Question: Provide a one-line summary of what is displayed.
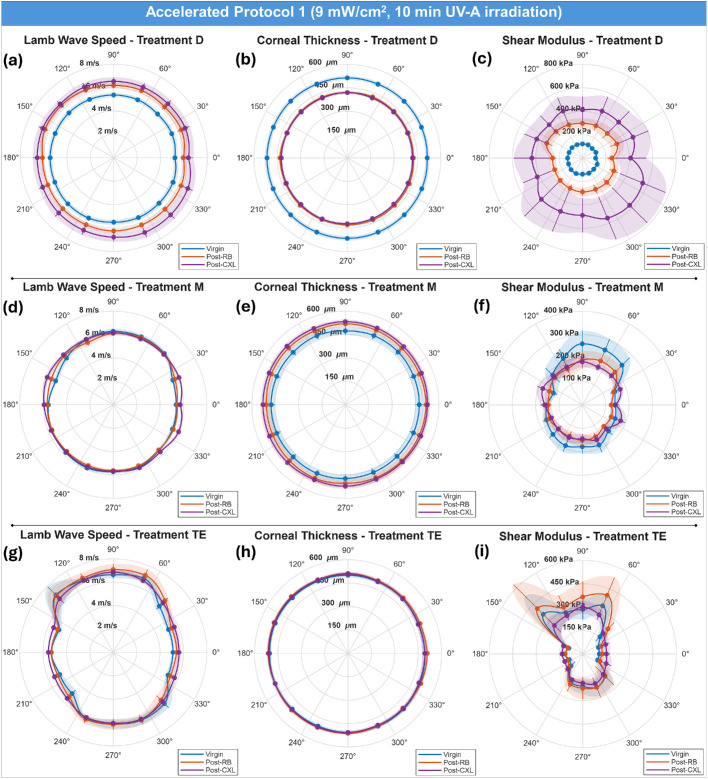
Answer: AP-1 multimeridian estimations. Group average meridian-dependent polar plots of Lamb wave speed ( left ), average corneal thickness ( center ), and estimated shear modulus ( right ) are shown in corneas in the Virgin, Post-RB, and Post-CXL phases when using photosensitizers D ( a , b , c ), M ( d , e , f ), and TE ( g , h , i ) and AP-1 (9 mW/cm 2 , 10 minutes of UVA). Scattered points shown mean values within a group. Standard errors (SD) for each meridian are shown in the plots as shadow patterns and bars.